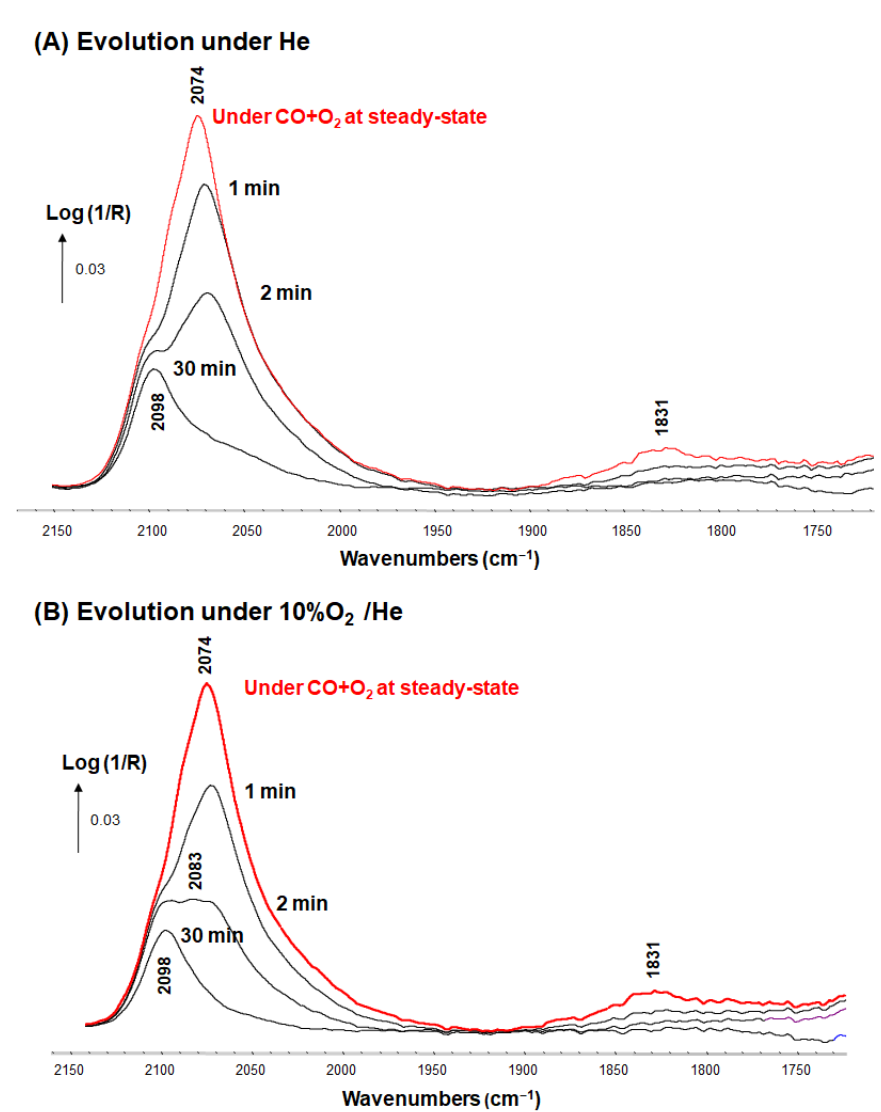
Figure 7. Evolution of DRIFTS spectra over Pt/CeO 2 recorded at 30 °C as a function of time under ( A ) pure He and ( B ) 10% O 2 /He. Total flow rate: 100 mL/min. The sample was previously left 15 min under 10% O 2 /He, and then 15 min under 0.5% CO + 10% O 2 /He to reach steady-state (Red spectra).